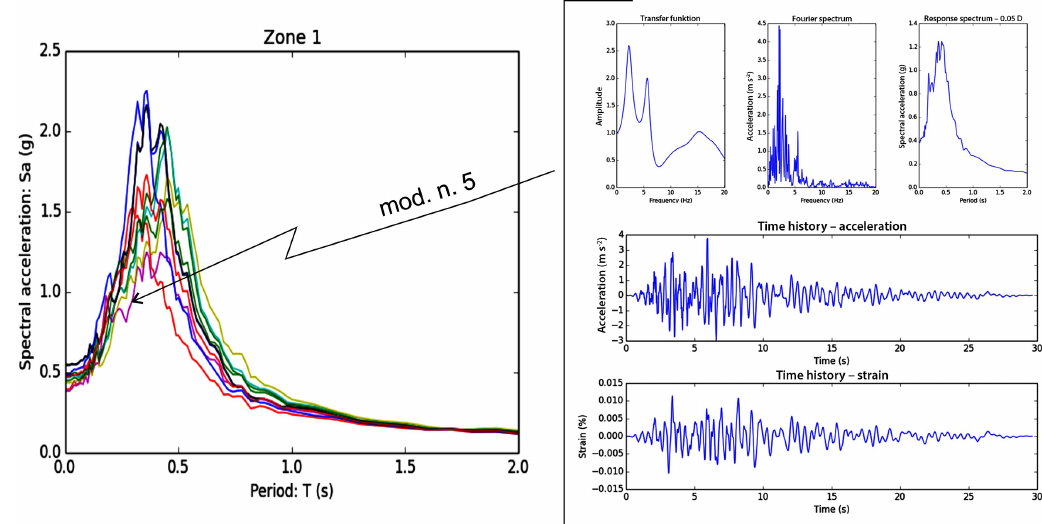
Figure 6. Example of the Stratigraphic seismic response set of zone 1 with 0.05 damping; for this set, the graphics plotted of the signal view module related to the fifth trainer V S – h model are also shown. In the analysis (all zones), the equivalent stress ratio is obtained by Eq. (13), taking into consideration a magnitude of